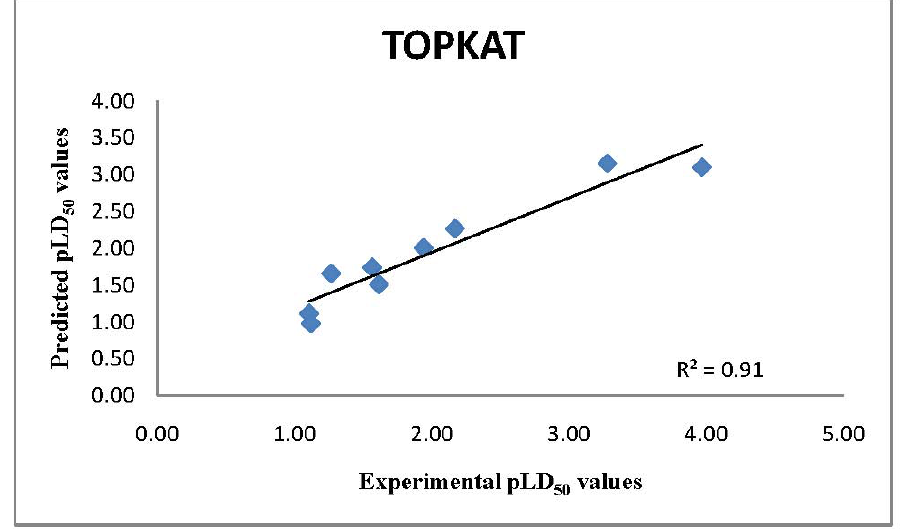
values with TOPKAT QSAR pLD 50